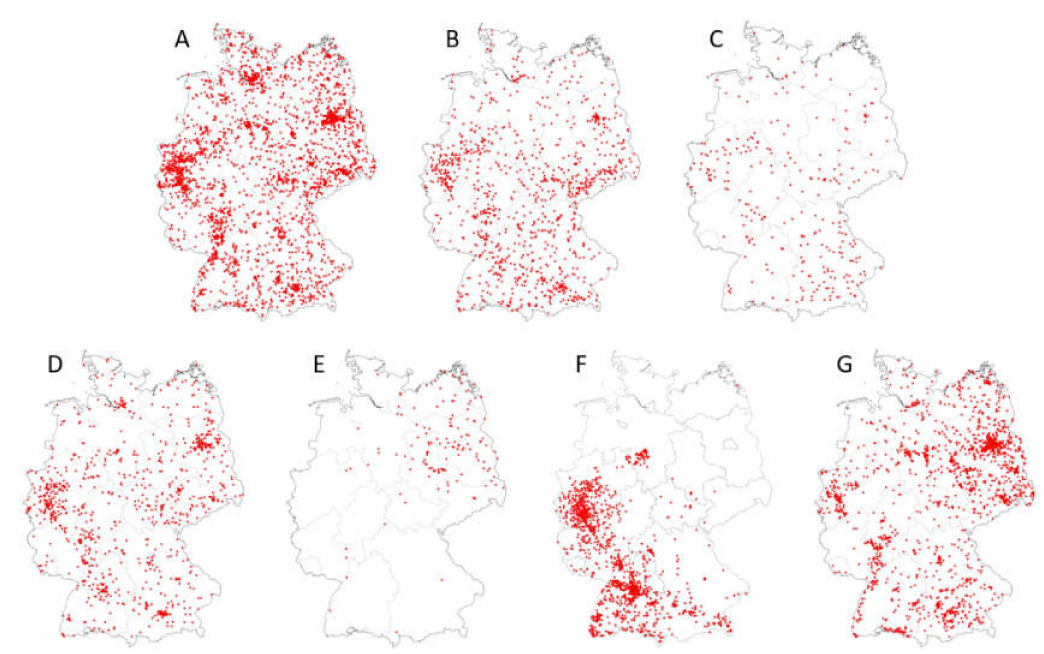
Figure 2. Distribution maps (presence data) of major potential WNV vectors in Germany (data extracted from CULBASE database, with collection dates from 2012 to 2018; red dots represent collections sites).